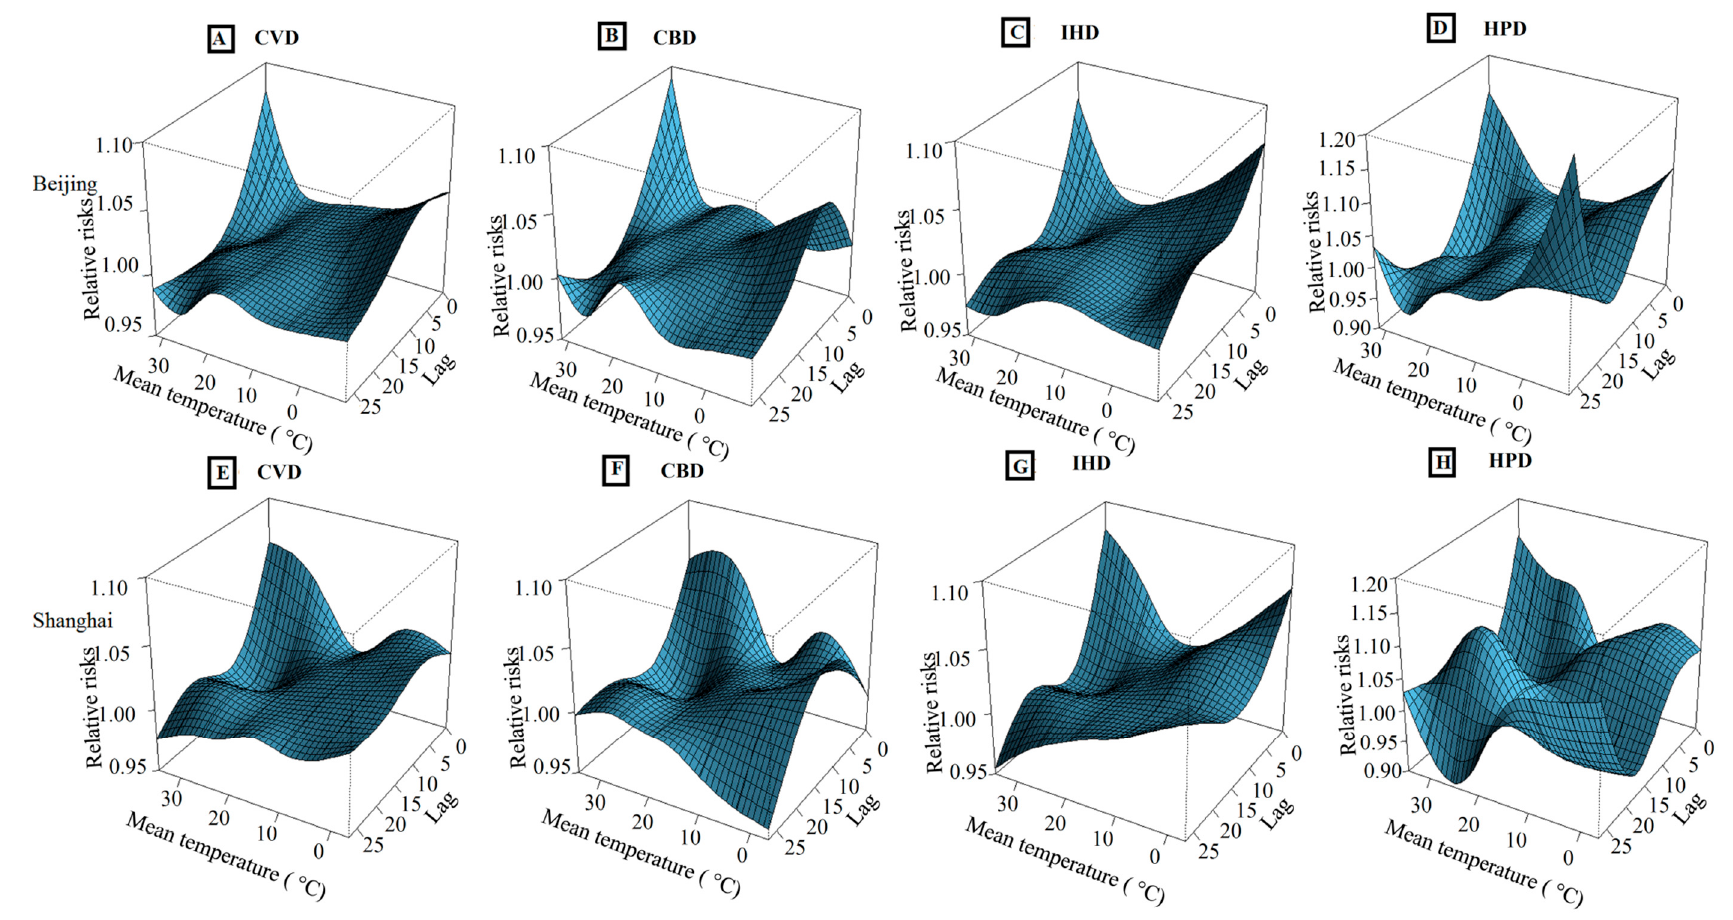
Figure A4. Three-dimensional graph of the relative risks for cause specific cardiovascular disease by mean temperature ( ˝ C) and lag days during 2007 and 2009 in Beijing and Shanghai, China (excluding the air pollution in the model)*. Note: * the effects of temperature on mortality from cardiovascular and cerebrovascular disease in two cities were excluded the influences of air pollution. The reference temperatures were 13.6 ˝ C for Beijing and 17.7 ˝ C for Shanghai, respectively; ( A – D ) represent the relative risks for mortality from CVD, CBD, IHD and HPD in Beijing, respectively; ( E – H ) represent the relative risks for mortality from CVD, CBD, IHD and HPD in Shanghai, respectively.